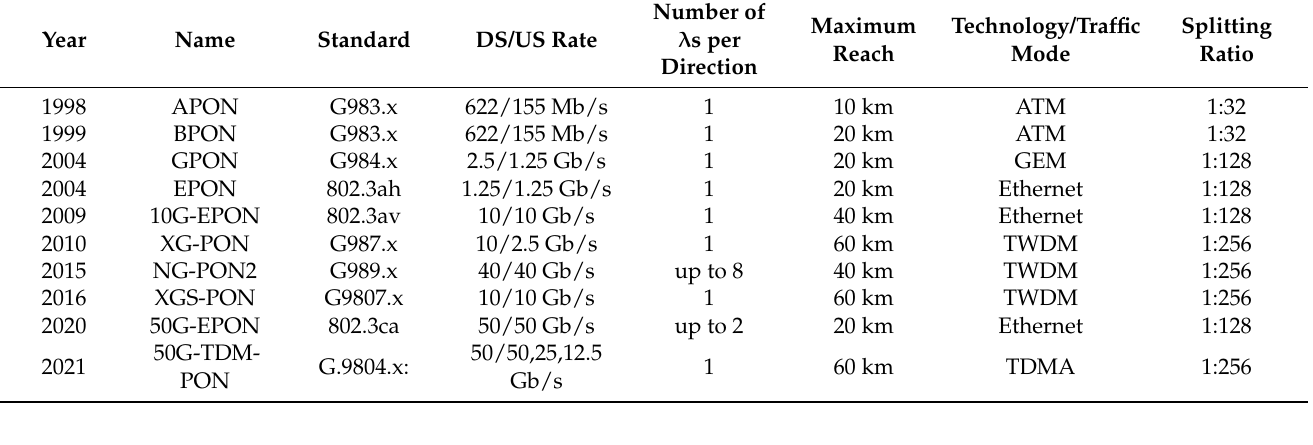
Table 4. Details of various fiber-based access standards.